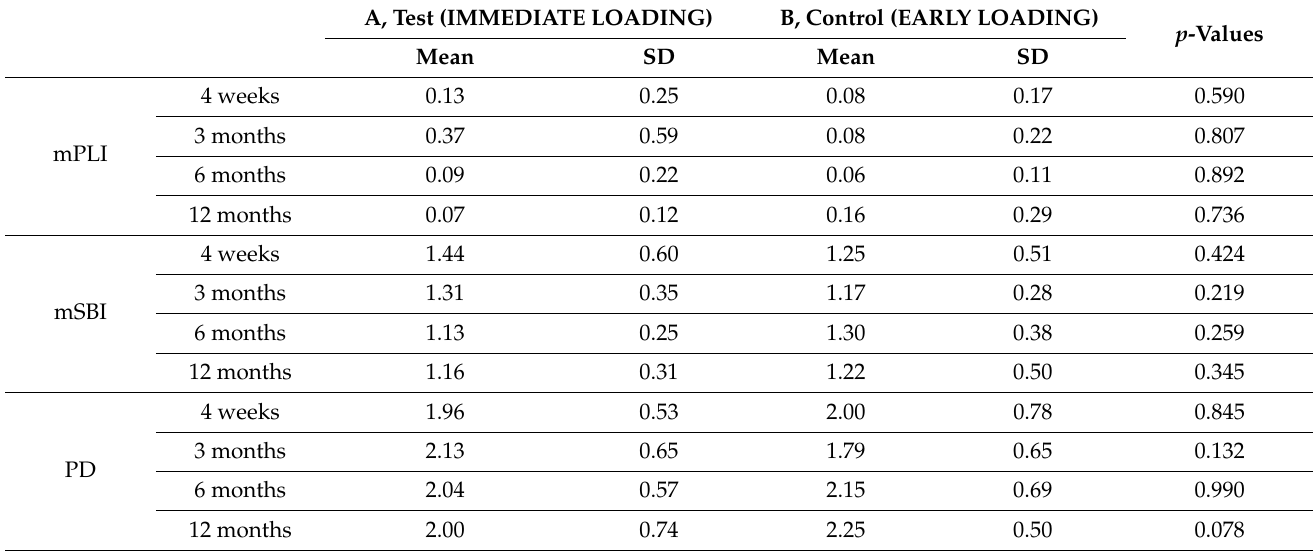
Table 1. Clinical variables. mPLI, modified plaque index; mSBI, modified sulcus bleeding index; PD, probing depth. A, Test (IMMEDIATE LOADING) B, Control (EARLY